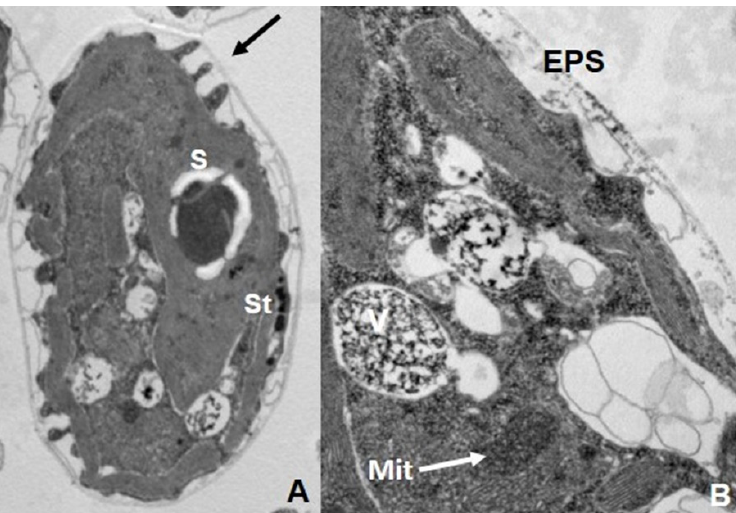
Figure 4. Ultrastructural damage in Chlamydomonas acidophila exposed to As(III) 5mM. Note the EPS secretion (arrow), stigma alteration, starch accumulation, and vacuolization. ( A ) General view of a vegetative cell ( × 20k). ( B ) Detail of a cell, showing mitochondrion degeneration (arrow), vacuoles ( × 50k). Note the electron-dense content of the vacuoles (V) that corresponds to As (TEM-EDX analysis). Mit: mitochondrion, St: stigma, S: starch, EPS: Extracellular Polymeric Substances.